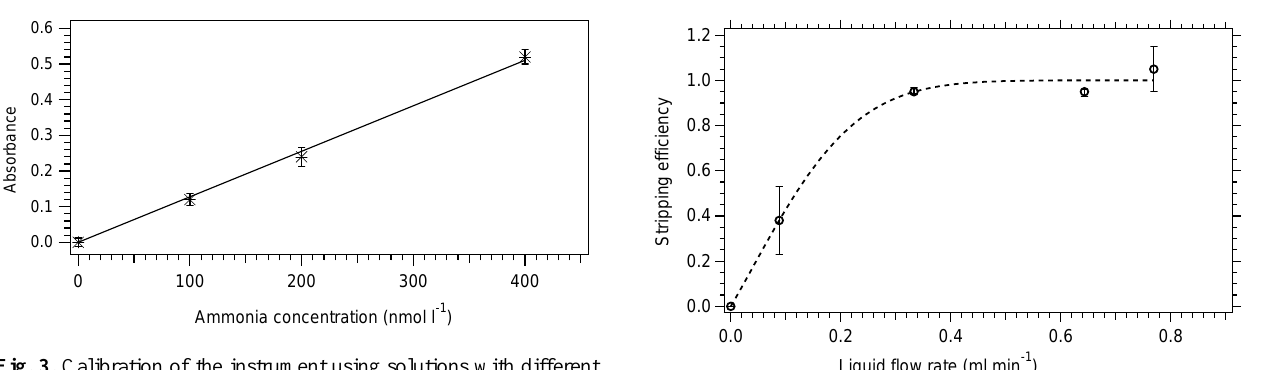
Fig. 3. Calibration of the instrument using solutions with different ammonia concentrations. The error bars represent one standard de- viation. The fit is forced through the origin. Fig. 4. Stripping efficiency versus liquid flow rate in the sampling line. Error bars represent 3 times the standard deviation of the mea- surements taken for each